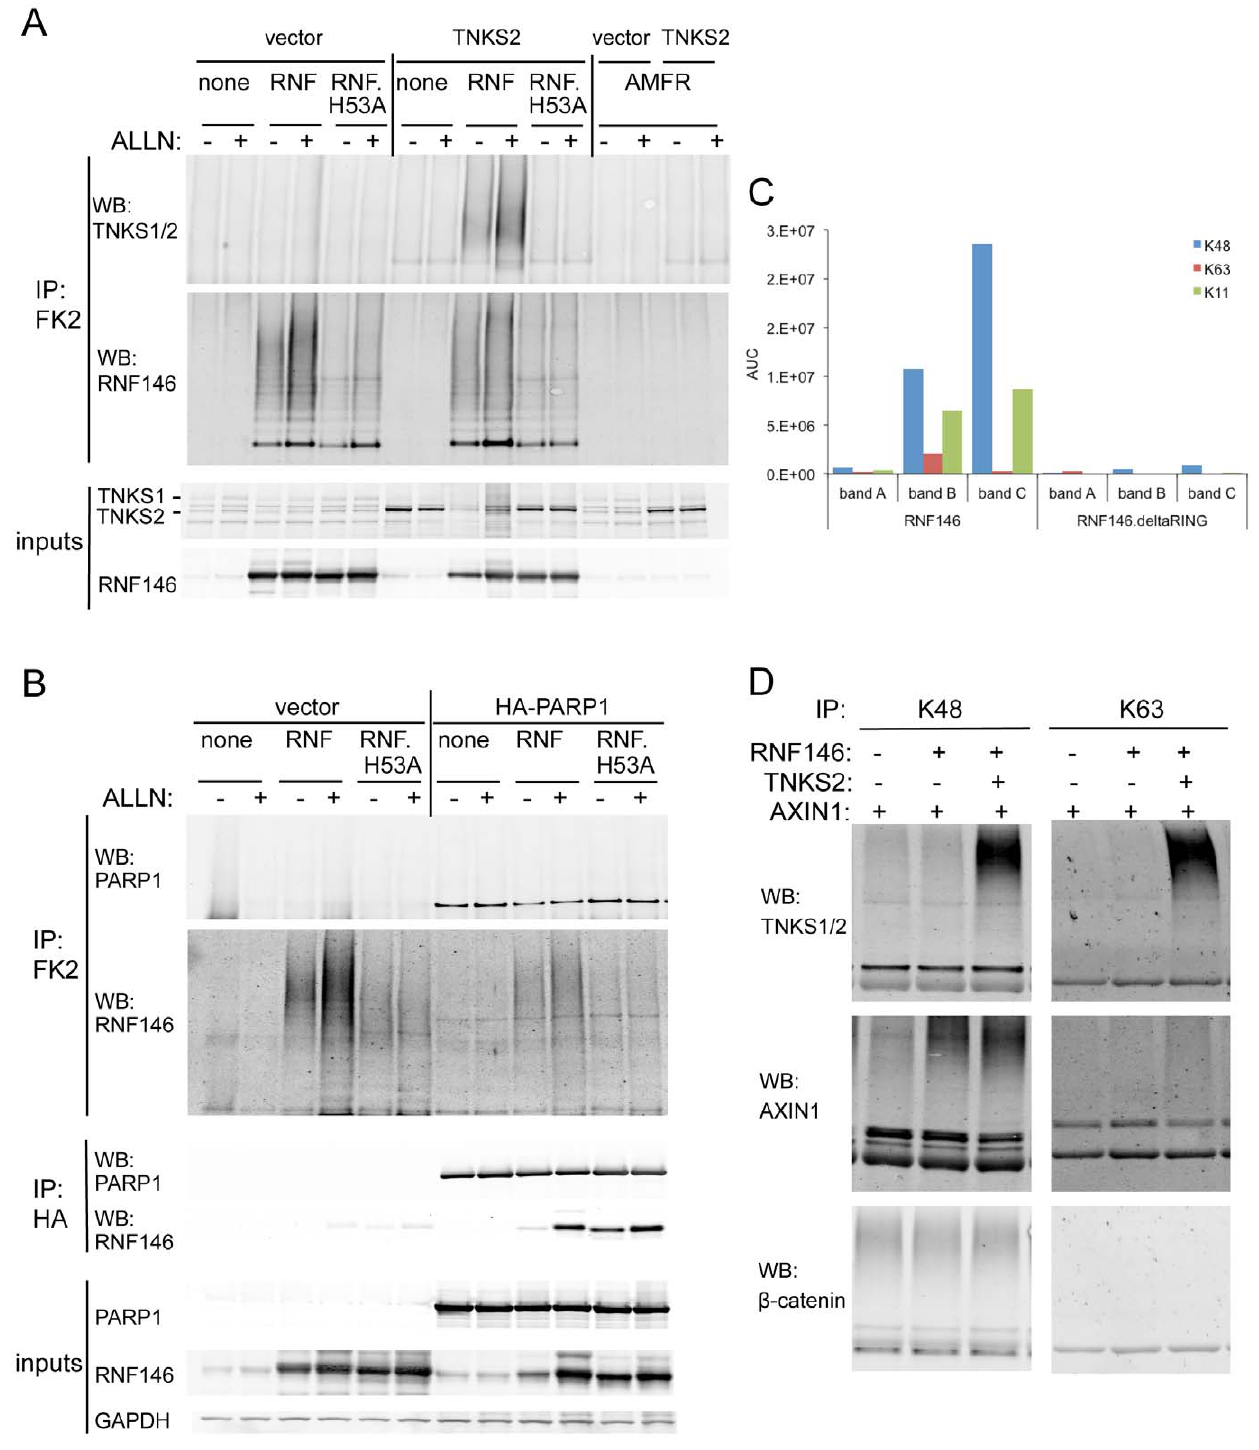
Figure 6. RNF146 ubiquitylates tankyrase and Axin in cells. (A) Western analysis of anti-ubiquitin (FK2 antibody) immunoprecipitation from HEK293 cells transfected with expression constructs for wildtype or H53A mutant RNF146 (RNF) or control E3 ligase AMFR, in combination with either TNKS2 or control vector DNA, without ( 2 ) or with ( + ) proteasome inhibitor ALLN treatment. Immunoblots are shown for ubiquitylated tankyrase and RNF146 smears. Input lysate immunoblots show expression levels of tankyrase and RNF146. (B) Western analysis analogous to (A) except that HA- tagged PARP1 is overexpressed rather that TNKS2. RNF146 binding to PARP1 is confirmed by anti-HA immunoprecipitation. (C) Relative quantitation of the area under the mass spectra curve (AUC) for K48-, K63-, and K11-linked polyubiquitin -GG signature peptides in excised gel bands A, B, and C depicted in Figure 5C. Results are shown for immunoprecipitation of wildtype or H53A mutant RNF146 proteins expressed in HEK293 cells. (D) Western analysis of immunoprecipitation with K48 or K63 linkage-specific polyubiquitin antibodies for the indicated overexpression of RNF146, tankyrase, or Axin in HEK293 cells. Immunoblotting for tankyrase, Axin, or control b -catenin proteins detects high-molecular-weight polyubiquitylated protein species. doi:10.1371/journal.pone.0022595.g006 PLoS ONE |